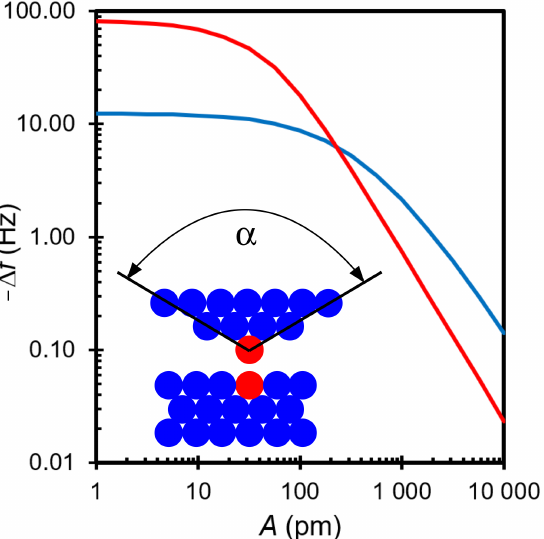
Figure 2. Frequency shift as a function of amplitude A for tip sample forces that are comprised of a van-der-Waals long range interaction and an exponential short range